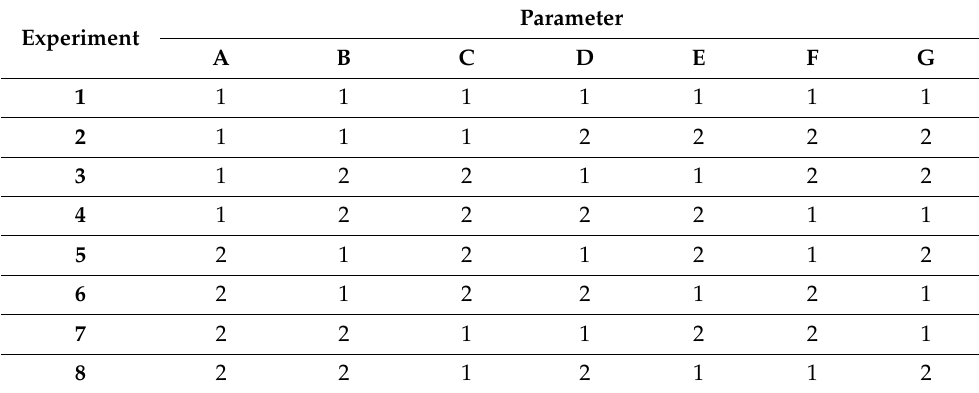
Table 2. 7-parameter (A, B, C, D, E, F, G) two-level (1, 2) experimental